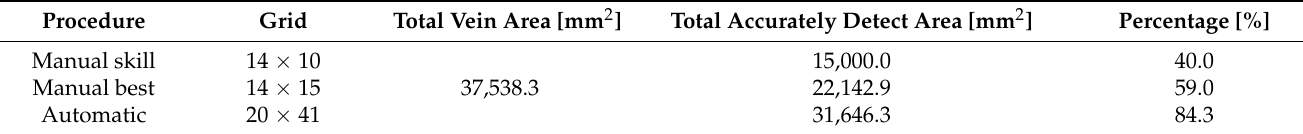
Table 6. Electric tomography—accuracy results.